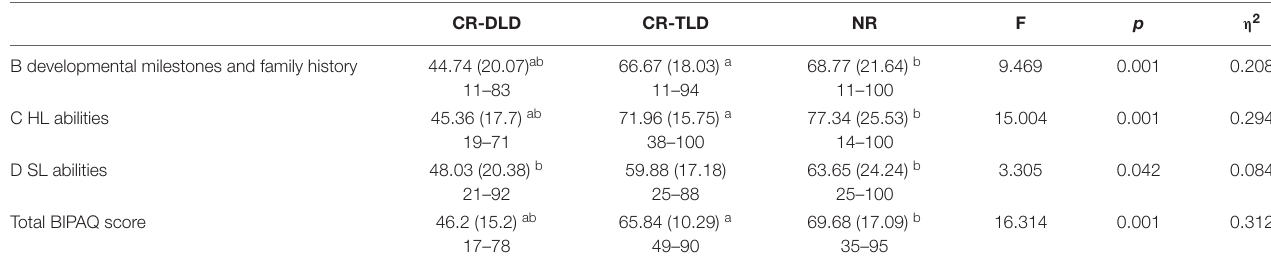
TABLE 2 | Scores of BIPAQ: CR-DLD, CR-TLD, NR in percentage [Mean (SD),